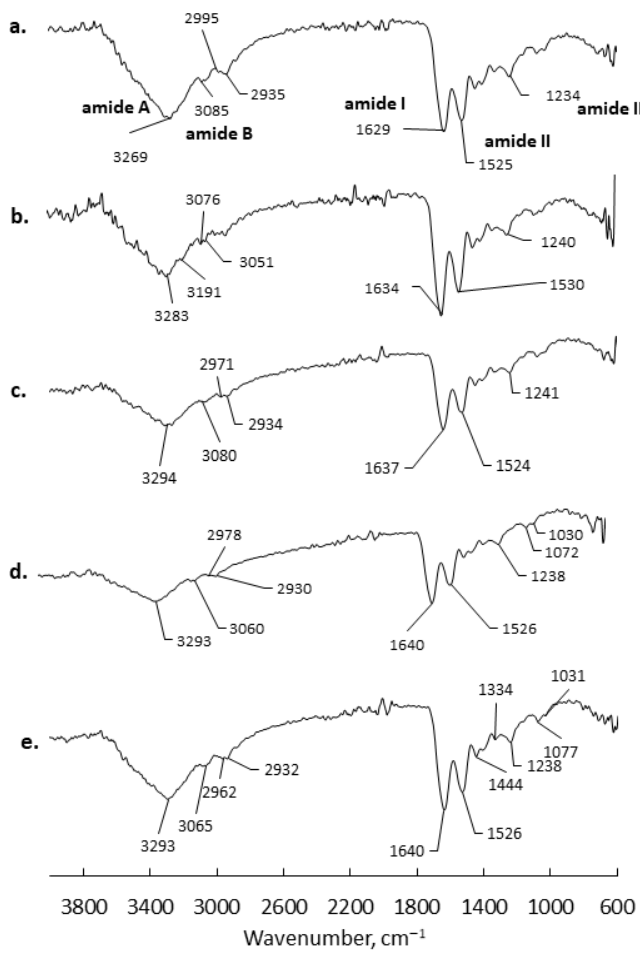
Figure 3. Representative ATR FTIR spectra recorded for the ( a ) raw fish gelatin, ( b ) FG fibrous mesh, ( c ) FG_GO mesh, ( d ) FG_ MNP mesh, ( e ) FG_GO_MNP. ( c ) FG_GO mesh, ( d ) FG_ MNP mesh, ( e )